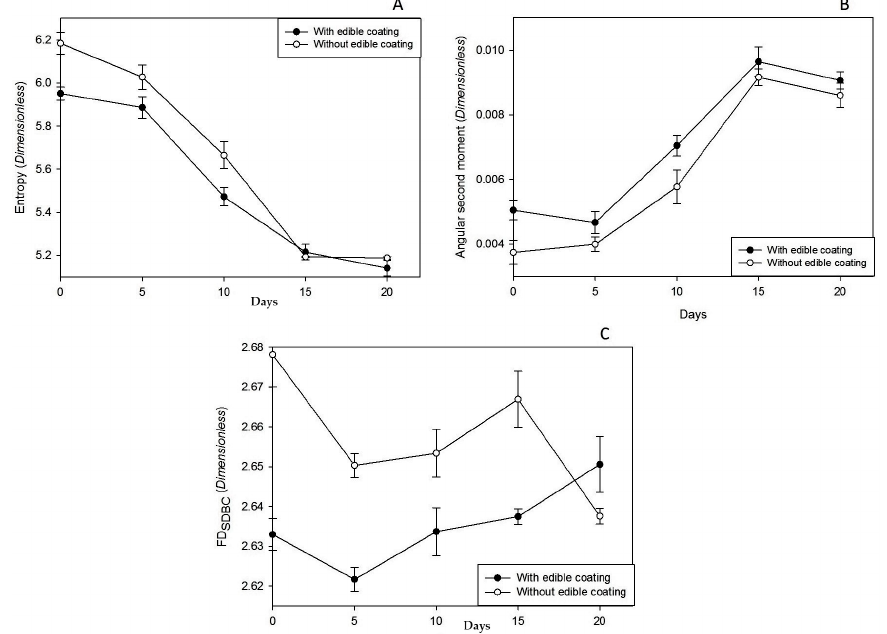
Figure 6. Image analysis of papaya with and without edible coating: ( a ) entropy; ( b ) angular second moment; ( c ) fractal dimension. moment; ( c ) fractal dimension.